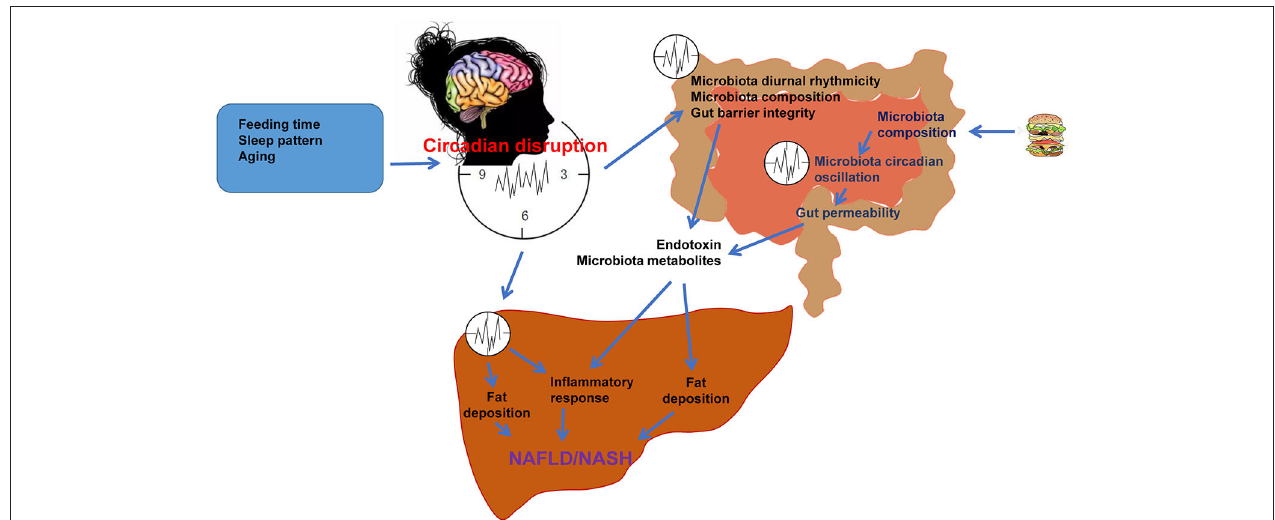
FIGURE 3 | Circadian rhythms and gut microbiota in the pathogenesis of NAFLD. Under normal physiological conditions, the central and peripheral clocks operate synchronously to maintain the normal operation of the body. Feeding time, sleep pattern, and aging cause circadian dysregulation, leading to alterations of microbiota diurnal rhythmicity, microbiota composition, and thus microbiota dysbiosis. Microbiota dysbiosis impairs gut barrier integrity and increases the gut permeability, which results in increased release of microbiota products such as endotoxin and microbiota metabolites into circulation. HFD or nutritional stress changes microbiota composition and circadian oscillation, increasing gut permeability and release of microbiota products. These microbiota products reach the liver and cause hepatic steatosis and inflammation, which are the features of NAFLD/NASH. Circadian disruption also directly causes dysregulation of liver metabolism, promoting NAFLD/NASH through increasing hepatic fat accumulation and